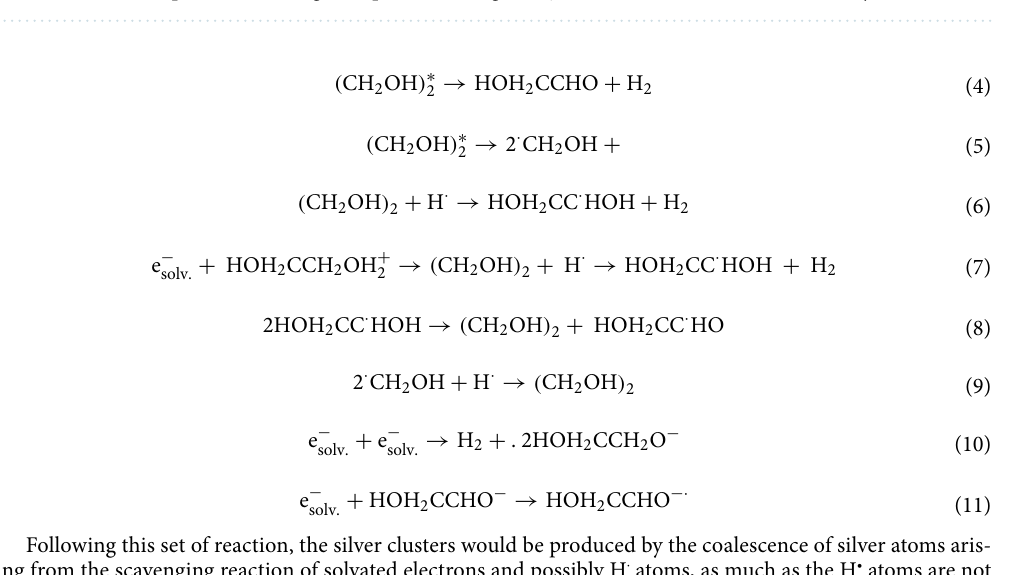
Figure 4. ( a ) Transmission electron microscopy images of the Ag nanoparticles in H 2 O and C 2 H 6 O 2 , ( b ) electron diffraction pattern of the Ag nanoparticles in Ag-C 2 H 6 O 2 radiolized at D 4 = 1.80 × 10 3